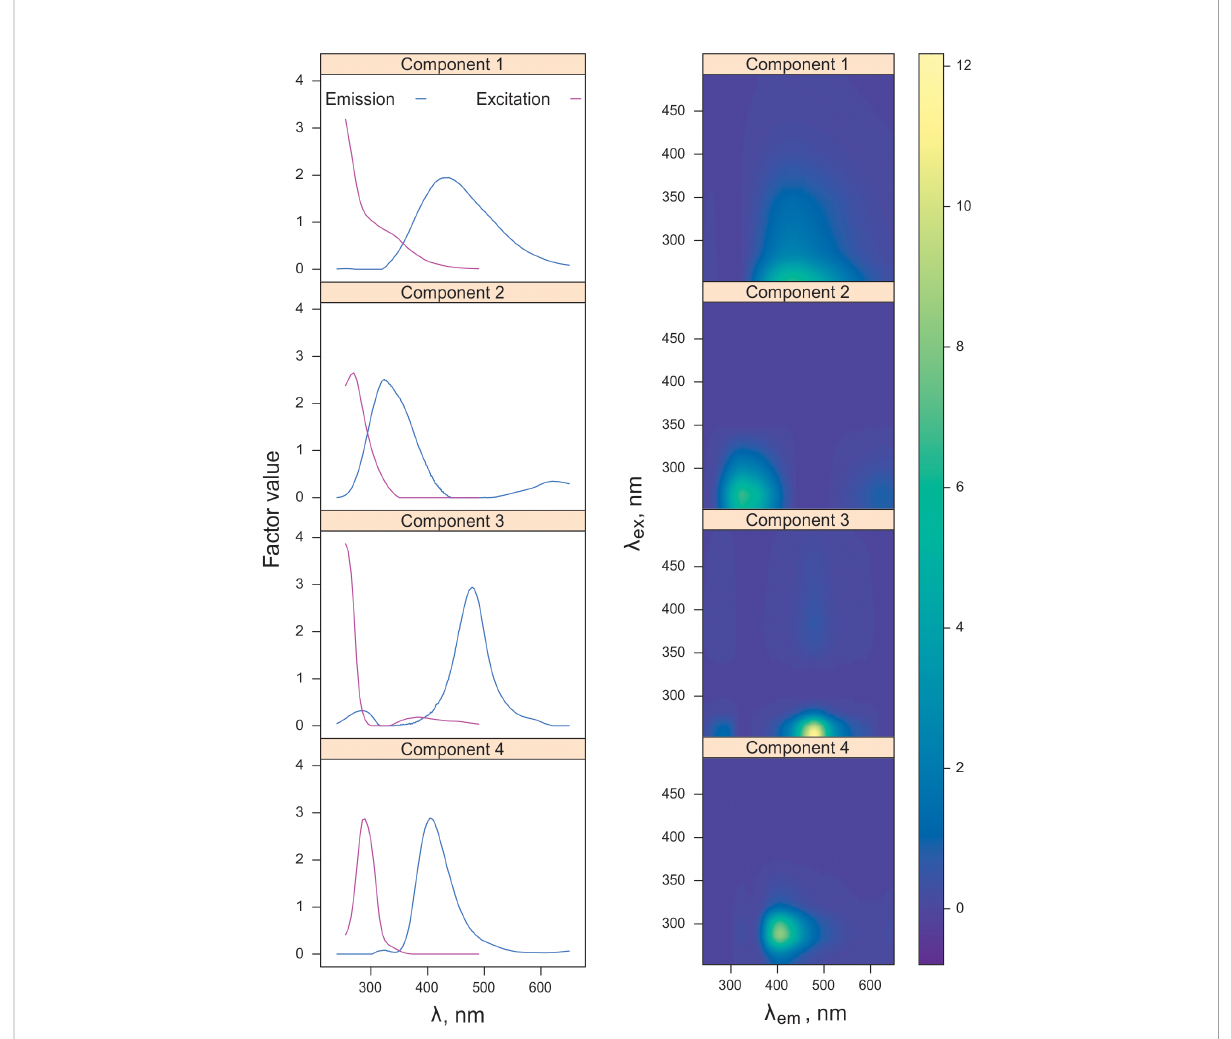
FIGURE 4 Excitation and emission spectra (left panel) and excitation-emission matrices (right panel) for each identi fi ed PARAFAC